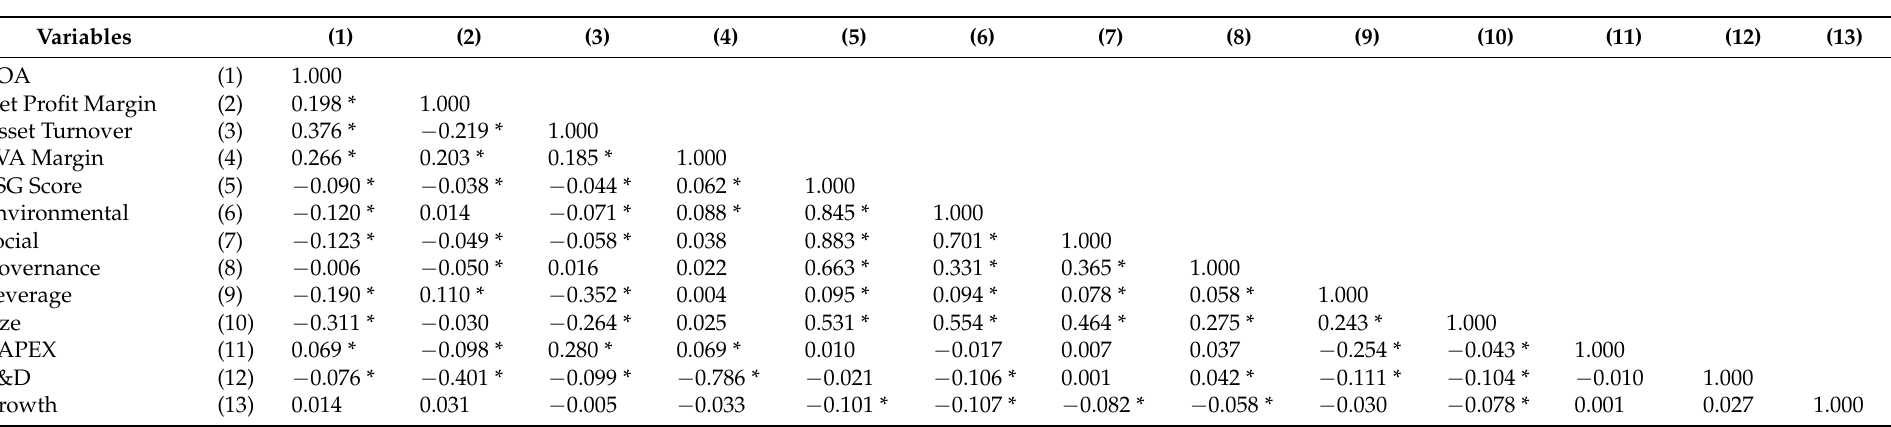
Table 3. Correlation